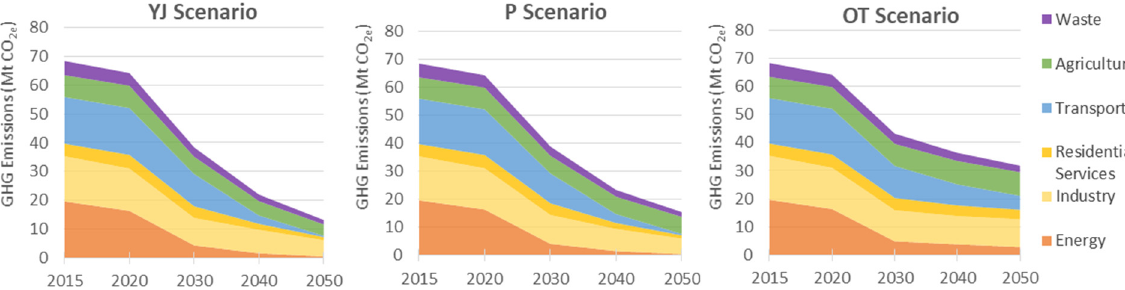
Figure 7. GHG emissions (Mt CO 2e excluding LULUCF) by sector and scenario: Yellow Jersey (YJ), Pack (P), and Off Track (OT).